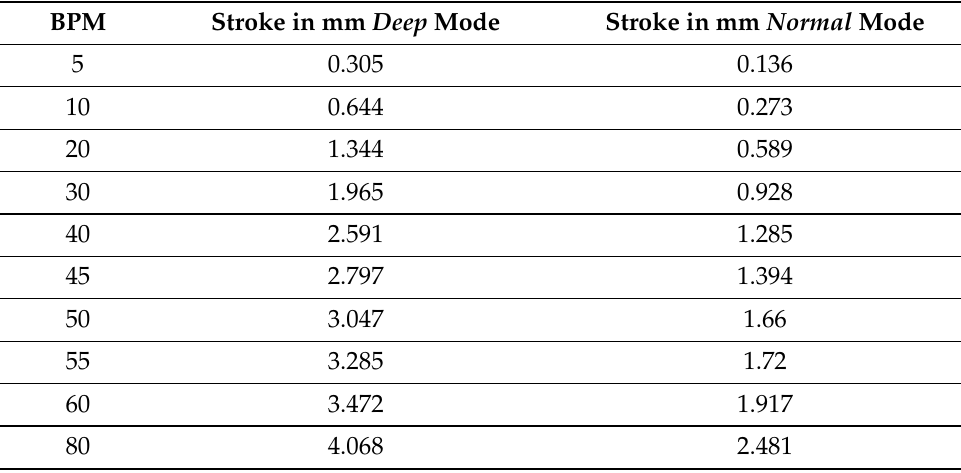
Table 2. Measured strokes with the laser micrometer in deep and normal